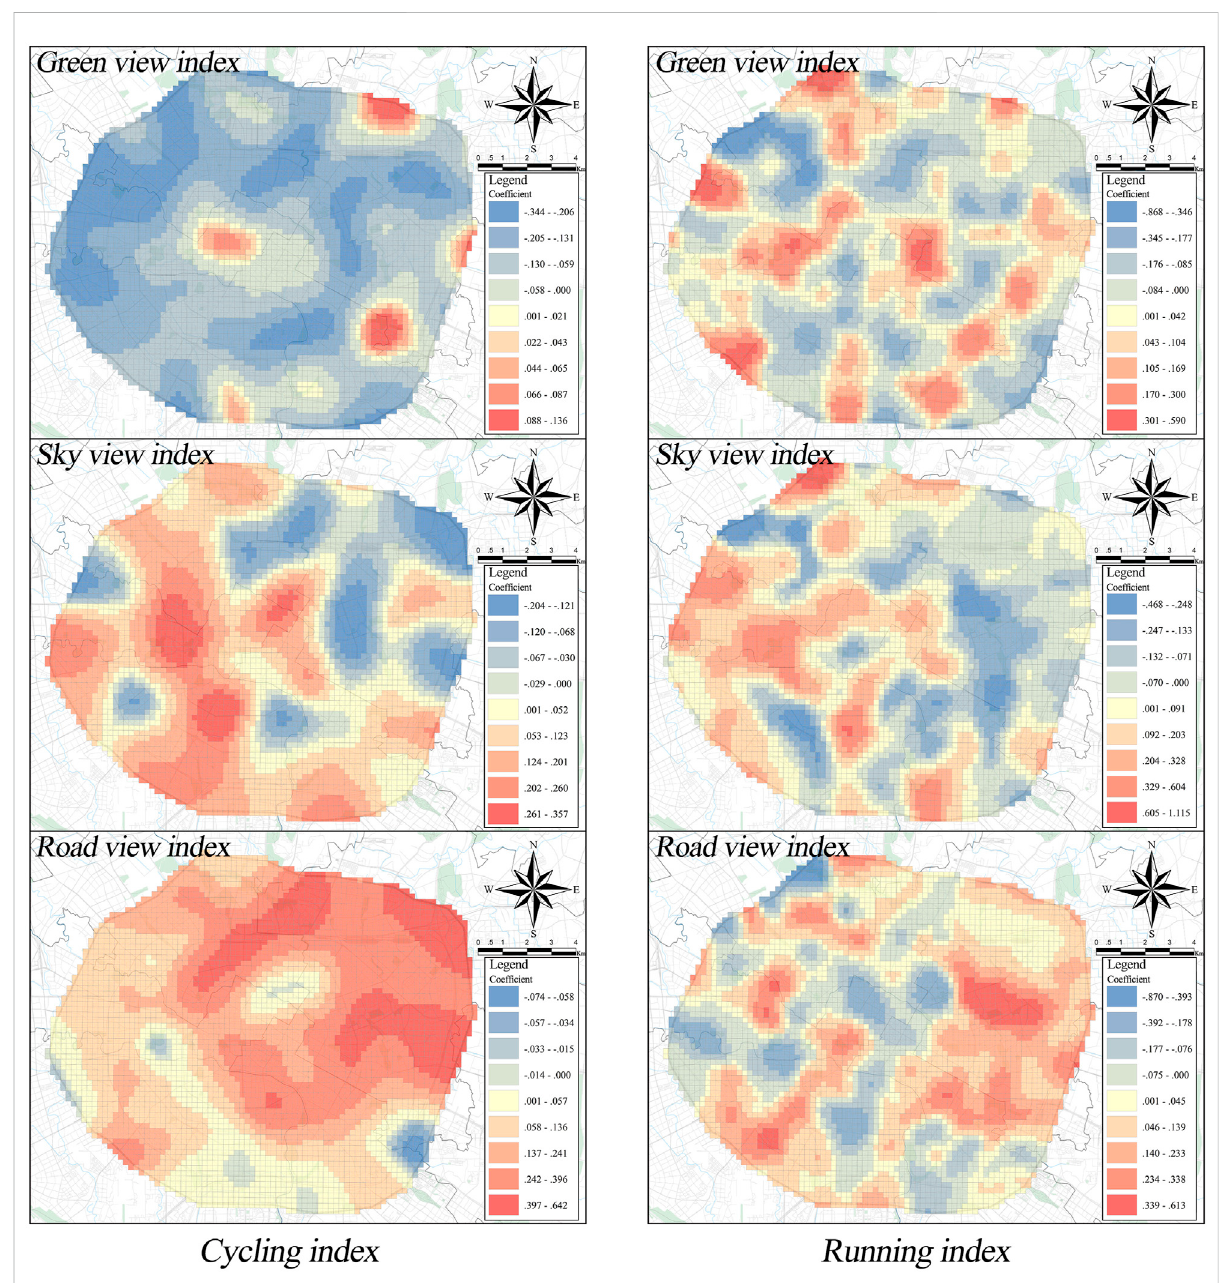
FIGURE 11 The spatial distribution of the coef fi cient of green view index, sky view index, and road view index in the GWR